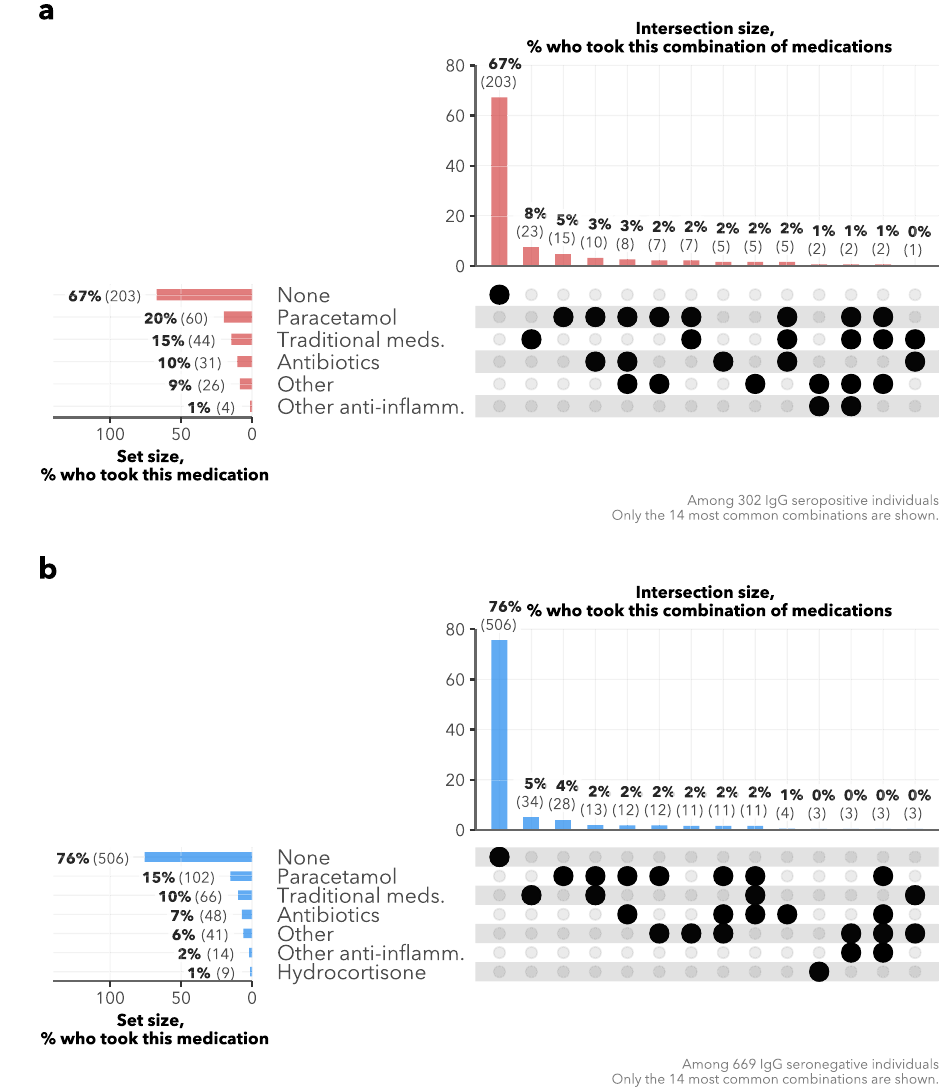
Fig. 4 Medications taken. Upset plots showing medications taken by a IgG seropositive and b IgG seronegative individuals, between March 1, 2020 and the date of survey. Horizontal bars to the left represent the percentage of respondents in each group who took the given medication. Vertical bars show the percentage of respondents in each group who took the combination of medications marked with the black dot(s) in that column. Meds: Medicines. Other anti-in fl amm other anti-in fl ammatory